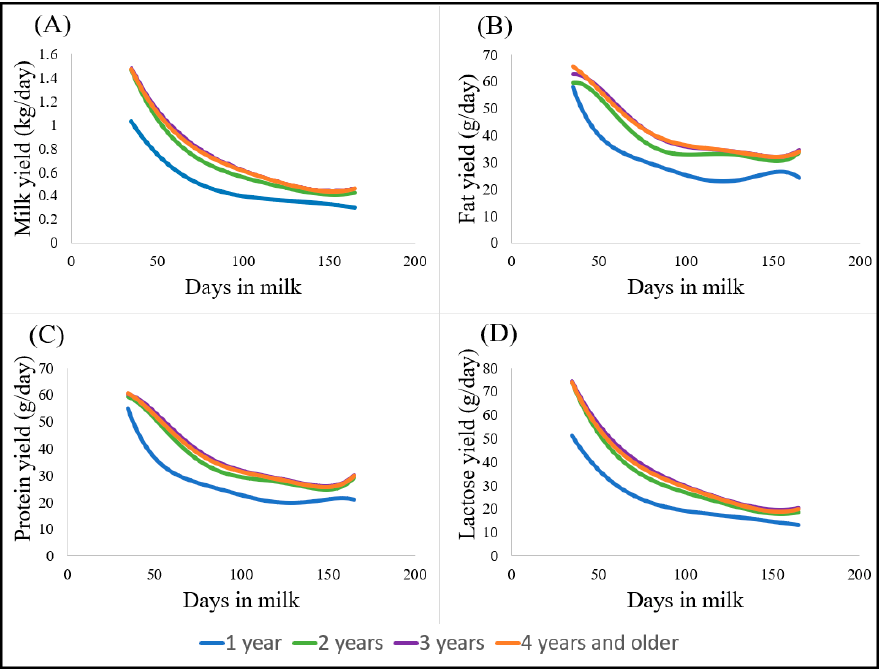
Figure 1. Lactation curves for daily yields of milk ( A ), fat ( B ), protein ( C ), and lactose ( D ) in lactations of Dairymeade ewes of one (blue), two (green), three (purple), and four years old or older (orange), modelled using orthogonal polynomials of order 4 for milk and lactose yields and of order 5 for fat and protein yields.